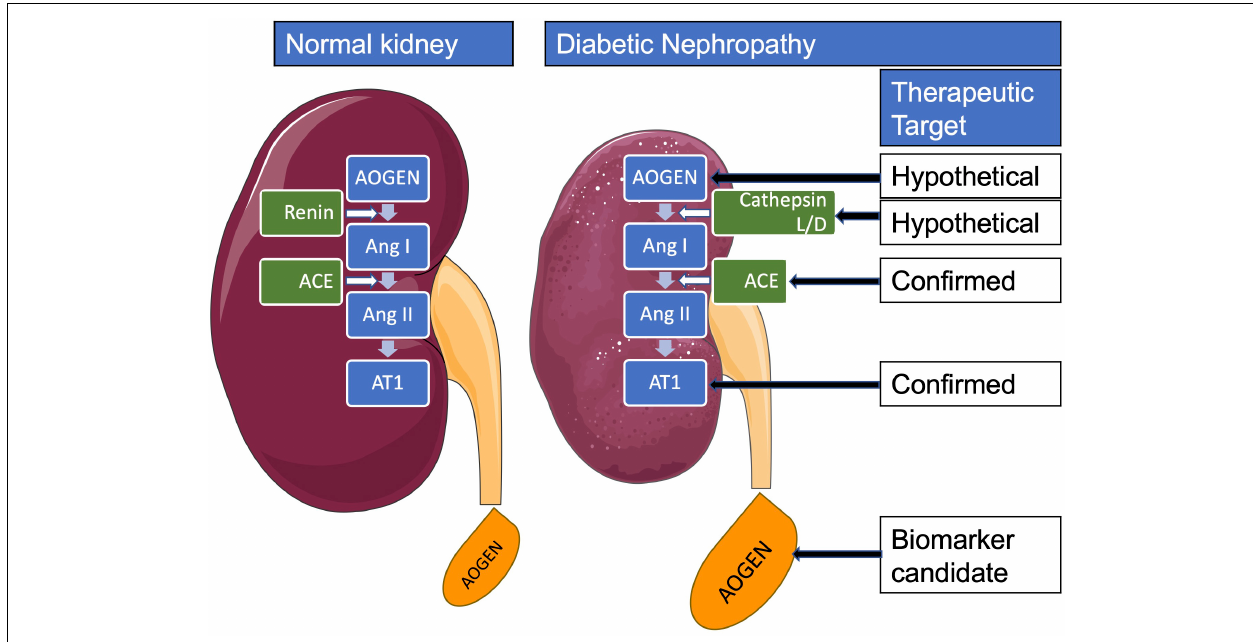
FIGURE 2 | Renal renin-angiotensin system in diabetes mellitus. AOGEN, angiotensinogen; ACE, angiotensin-converting enzyme; Ang, angiotensin; AT1, angiotensin type 1 receptor.